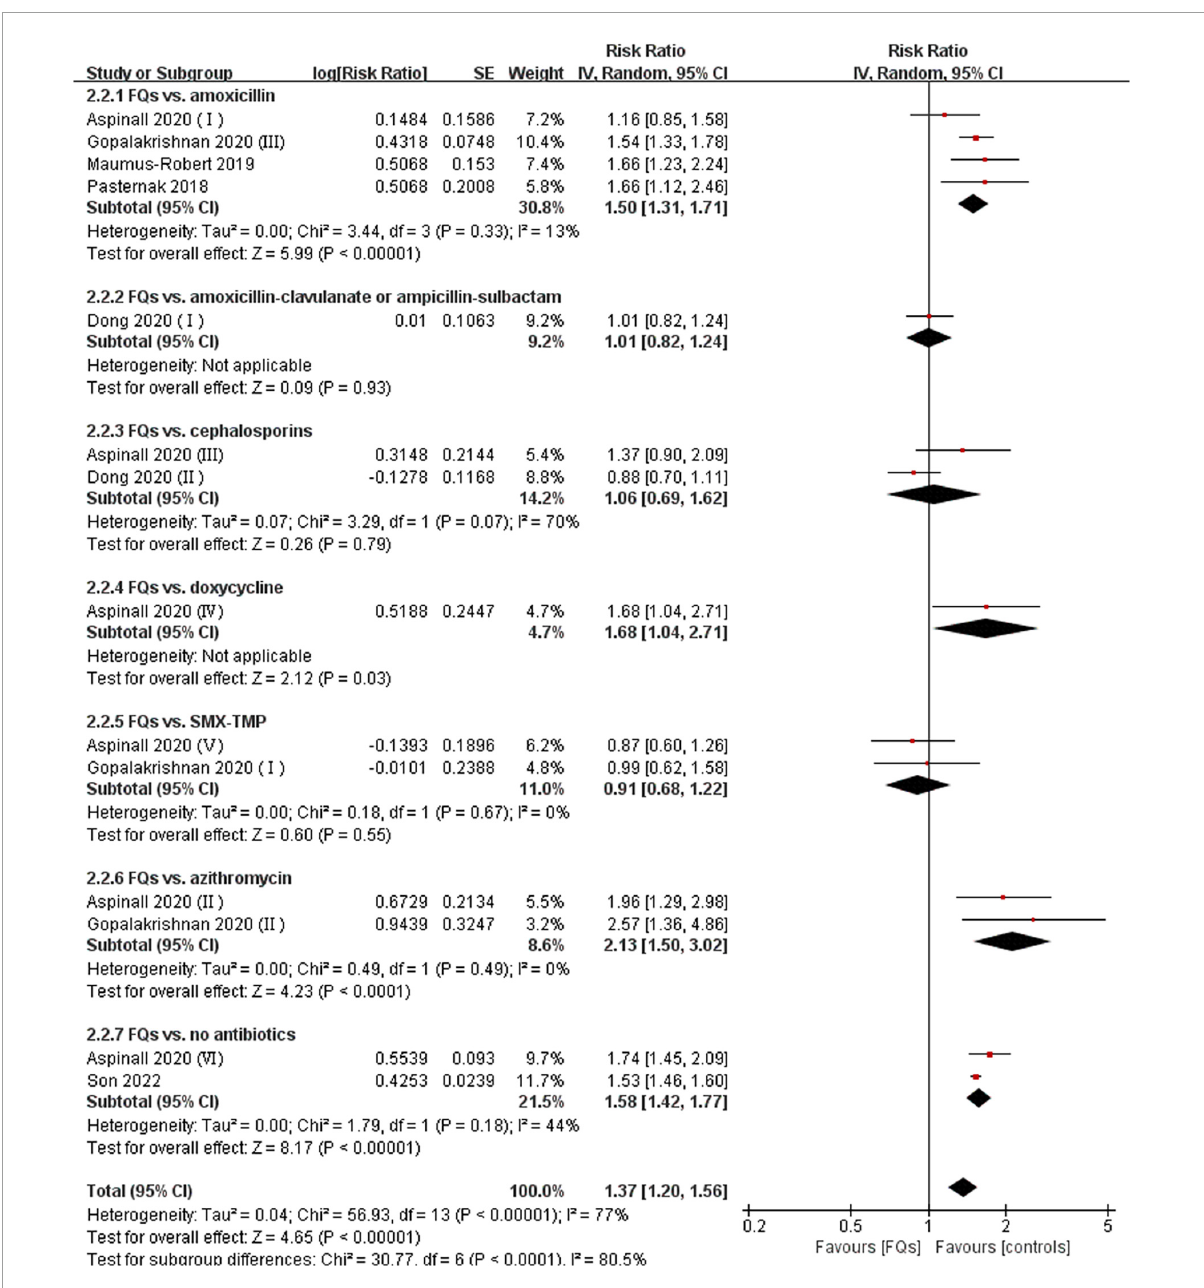
FIGURE3 Forest plot of the risk of aortic aneurysm or dissection (AAD) in the comparison of fluoroquinolones (FQs) vs. controls within a 60-day risk period. FQs, fluoroquinolones; SMX-TMP, combined trimethoprim and sulfamethoxazole; IV, inverse variance; CI, confidence interval.